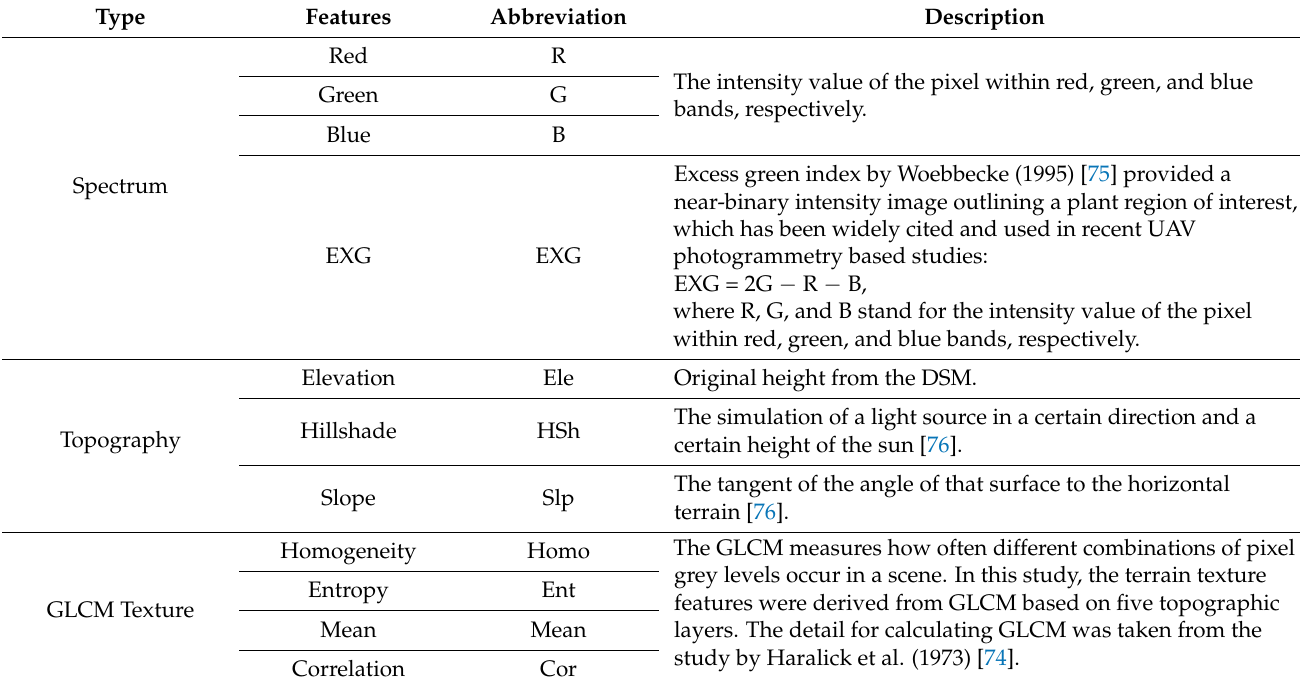
Table 1. Overview of the features used for